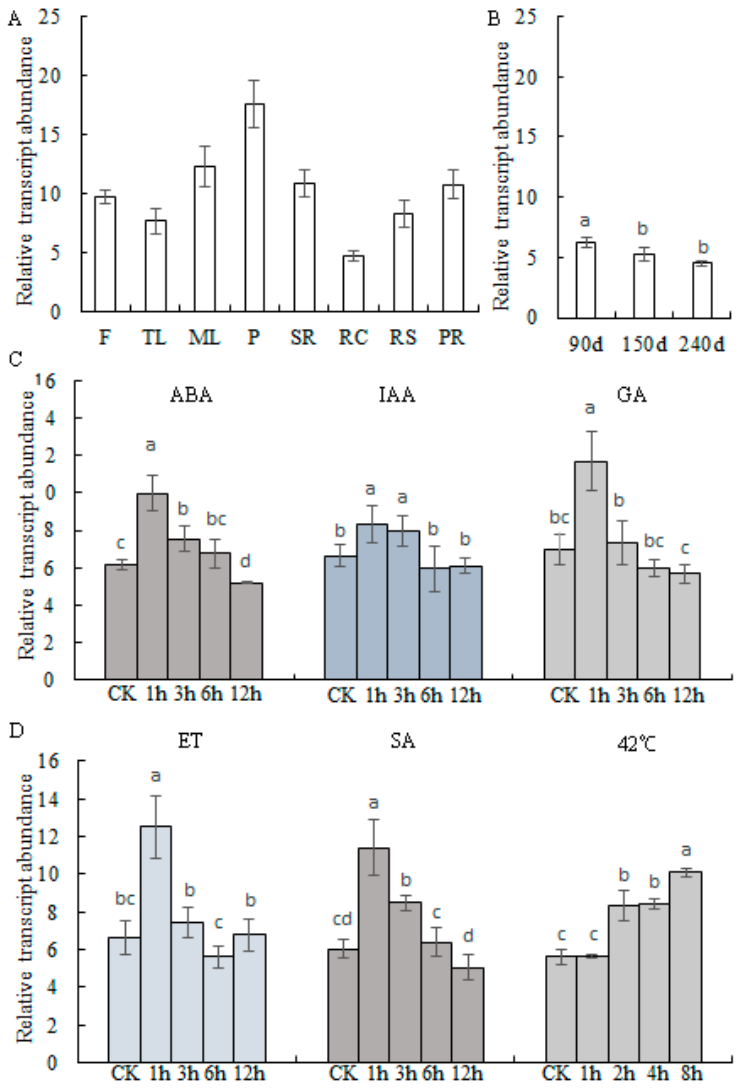
Figure 3. Transcription profiles of MePHD1 . ( A ) Expression profile of MePHD1 in different organs